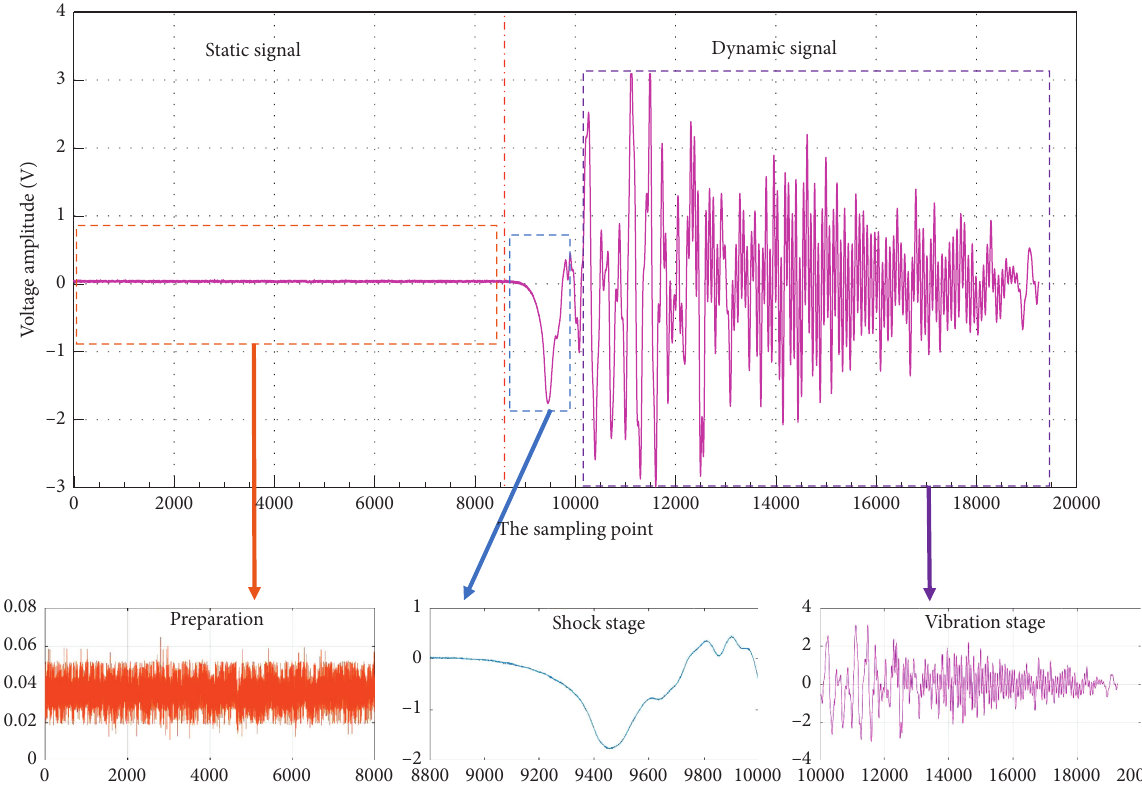
Figure 7: The output signal of the accelerometer.